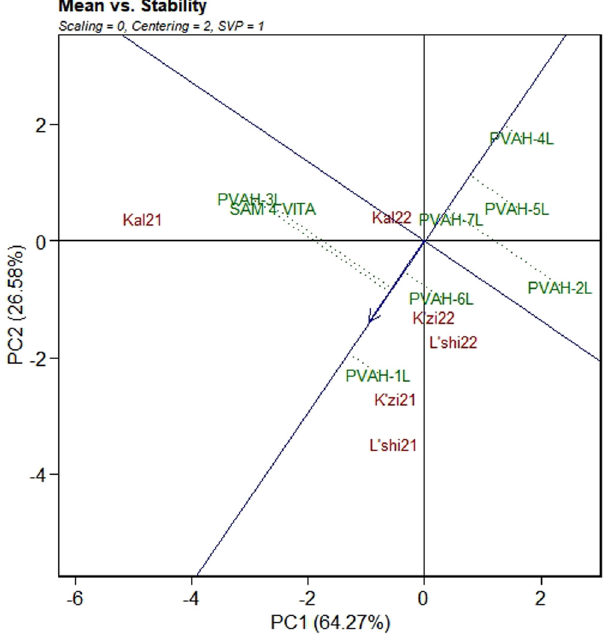
Figure 1: Genotype, genotype by environment biplot showing the mean and stability of eight provitamin A maize genotypes evaluated across six environments.